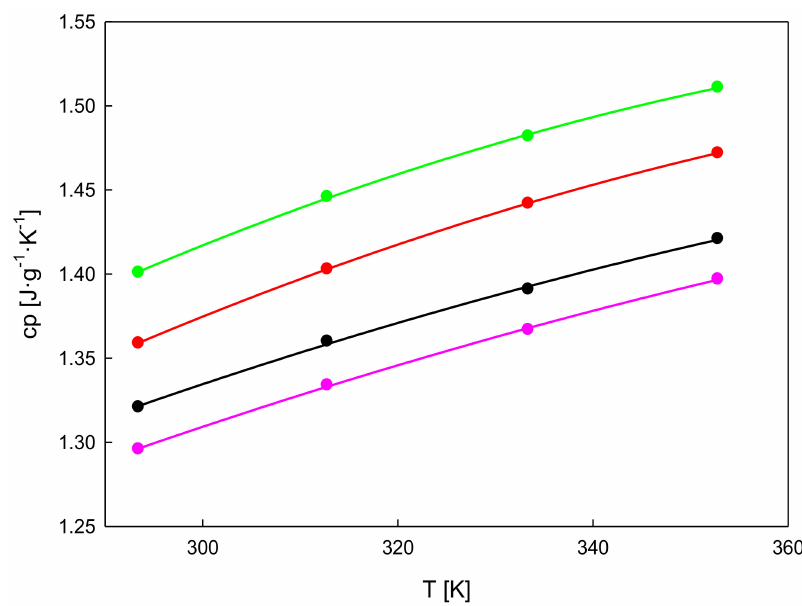
Figure 4. Isobaric specific heat capacity, c p , vs. temperature, of the xGnP / [C 2 C 1 py][C 4 F 9 SO 3 ] at mass concentrations: (—) 0 wt%, (—)1 wt%, (—) 5 wt%, (—)10 wt% at 293.15 K.